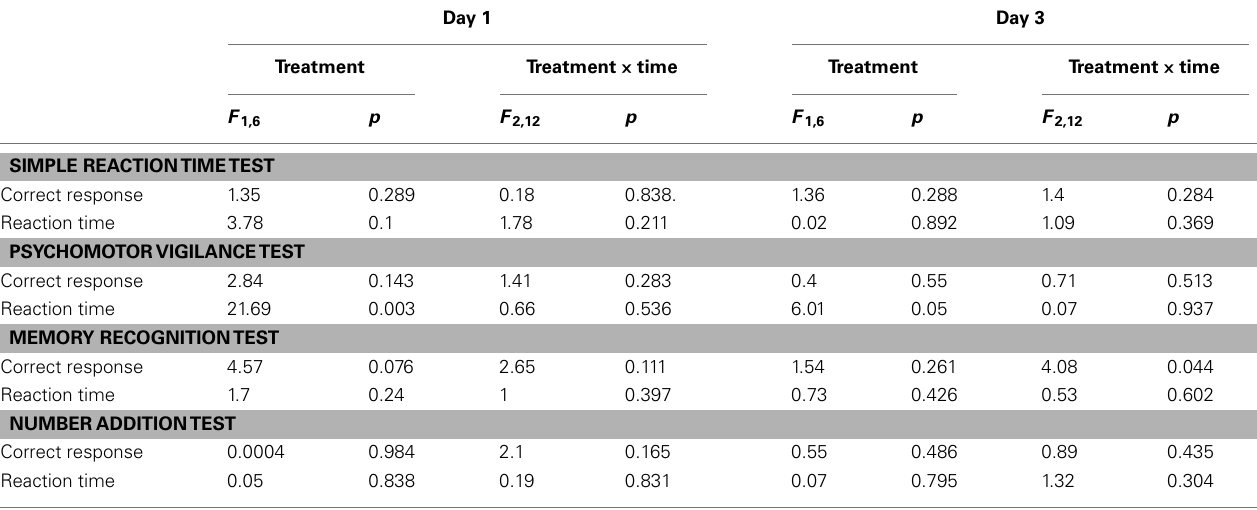
Table 2 | Statistical analysis of performance test.